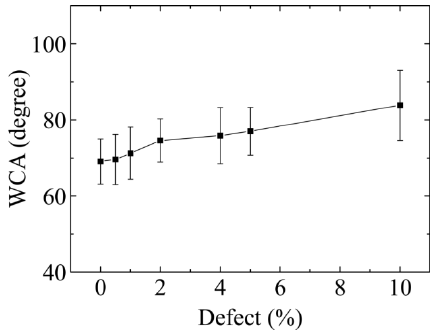
Figure 4. Water contact angles of droplet sessile on GO surface as a function of surface defect concentration.